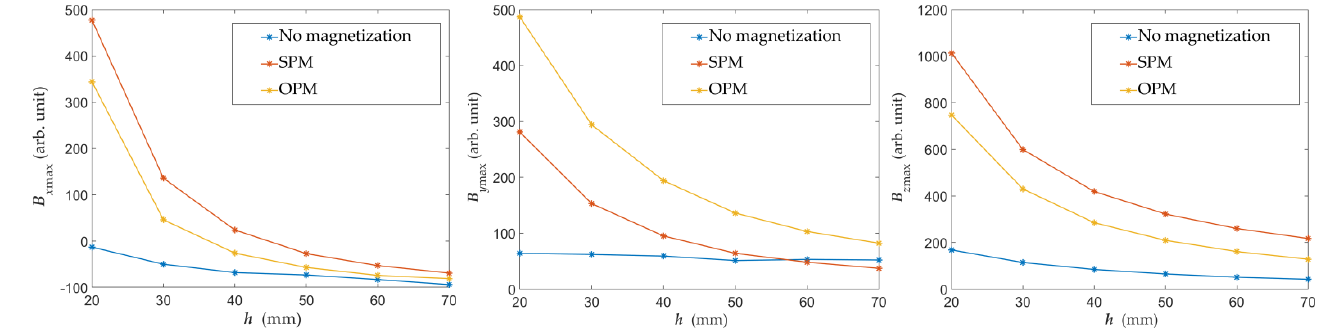
Figure 18. Graphs of the maximum value of the magnetic field components as a function of the concrete cover thickness h obtained for various magnetization methods.